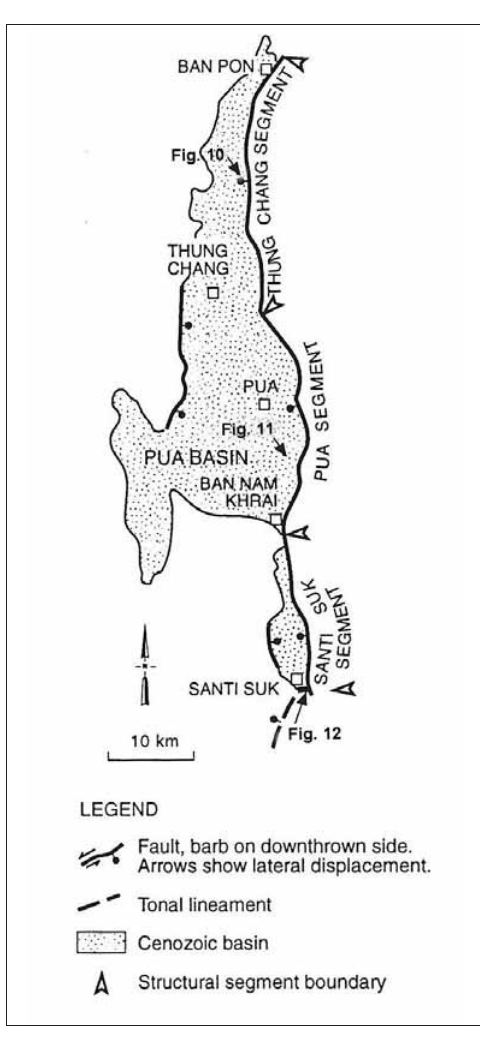
Fig. 9. Simplified map of the Pua Fault System show- ing fault segments and localities mentioned in the text.